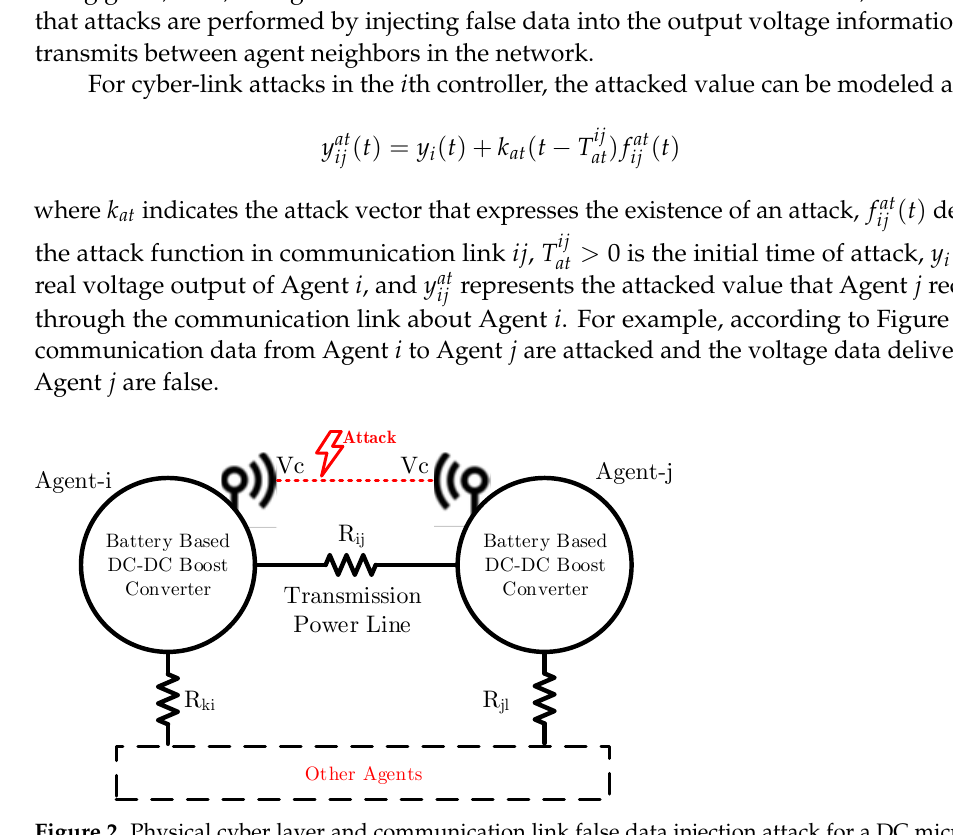
Figure 2. Physical cyber layer and communication link false data injection attack for a DC